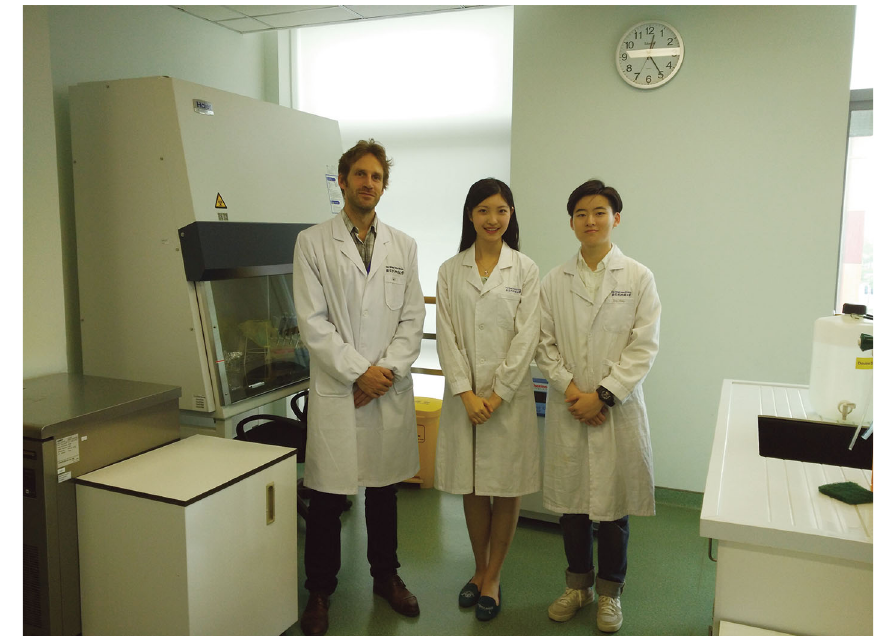
Figure 3. Posing in my lab at XJTLU together with two students, Xinzhu Fei (middle) and Jing Zhang